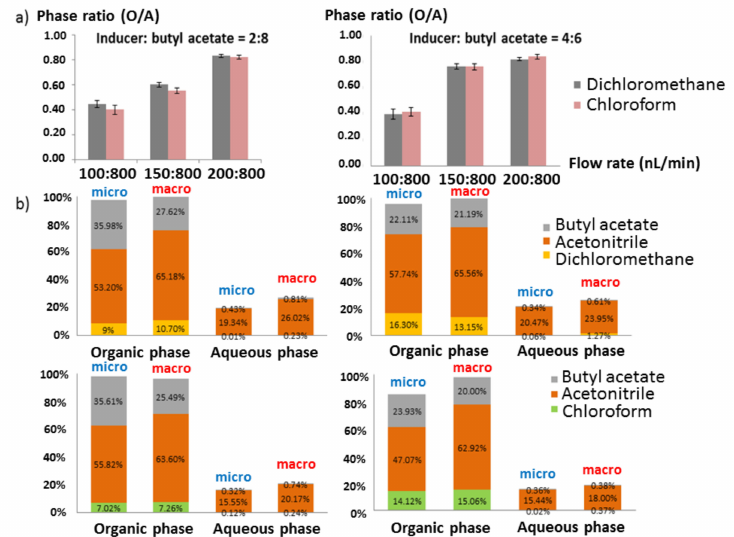
Figure 2. ( a ) Phase ratio as a function of inducer flow rates (0.10, 0.15 and 0.20 µ L/min), nature of inducer (dichloromethane or chloroform) and volume ratio of inducer and butyl acetate (2:8 or 4:6); ( b ) relative volume percentages of collected organic and aqueous phases at microscale (IPSE chip) and macroscale (Eppendorf tube) for both dichloromethane (upper) and chloroform (bottom) used at the optimal flow conditions. Volume ratio of inducer and butyl acetate is 2:8 (left) and 4:6